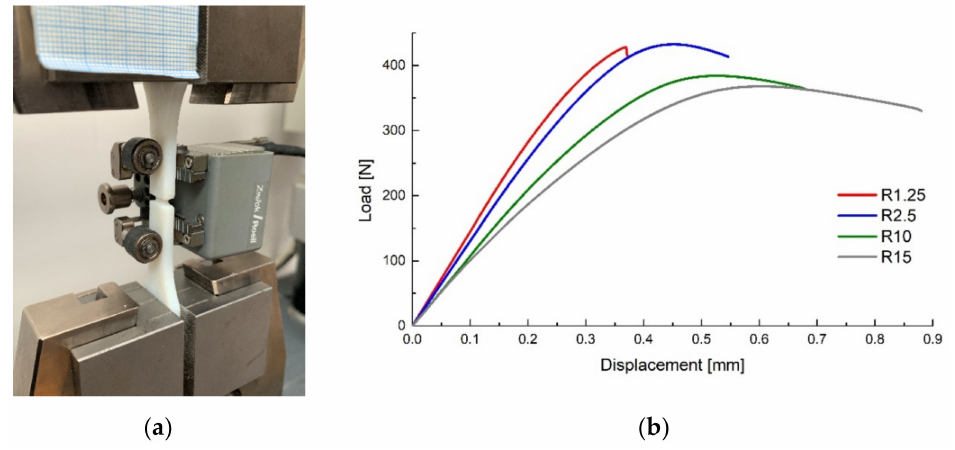
Figure 2. Experimental setup ( a ) and force–displacement curves for the tensile specimens ( b